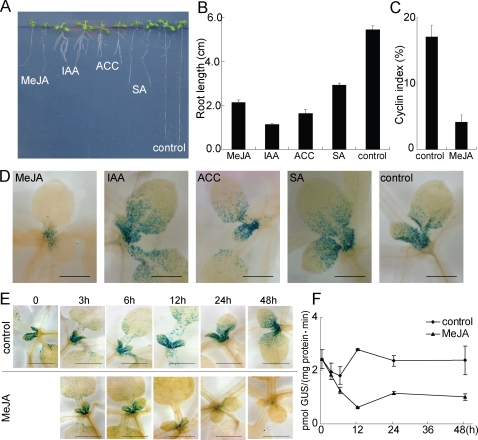
Effect of MeJA, IAA, ACC, and SA on growth and GUS expression in wild type Col-0 plants containing CycB1;2::GUS transgene.(A) Four-day-old seedlings were transferred to MS as control or to MS containing MeJA (50 µM), IAA (2 µM), ACC (10 µM) or SA (50 µM) for 10 days. (B) Root length of 14 days old seedlings growing on media containing MeJA, IAA, ACC, and SA. (C) Cyclin index of control and MeJA treated plants from (A). (D) Histochemical detection of GUS in seedlings from (A). Scale bar, 0.5 mm. (E) Twelve-day-old seedlings grown on MS media were transferred to MS as control or to MS containing 50 µM MeJA. GUS was detected histochemically at the indicated intervals after transfer. (F) Twelve-day-old seedlings grown on soil were sprayed with water as control or 500 µM MeJA, and again at the intervals at which samples were taken. GUS activity in the samples was measured by the MUG assay. Data points are means of three samples of 60 seedlings each.